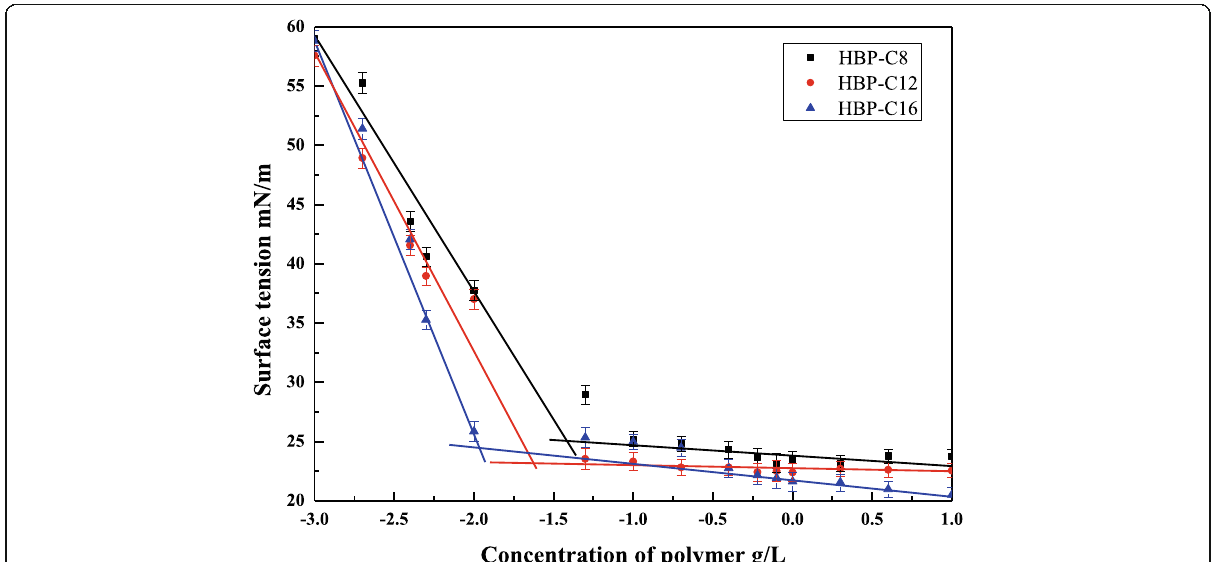
Fig. 7 Surface tension of HBP-C8, HBP-C12,